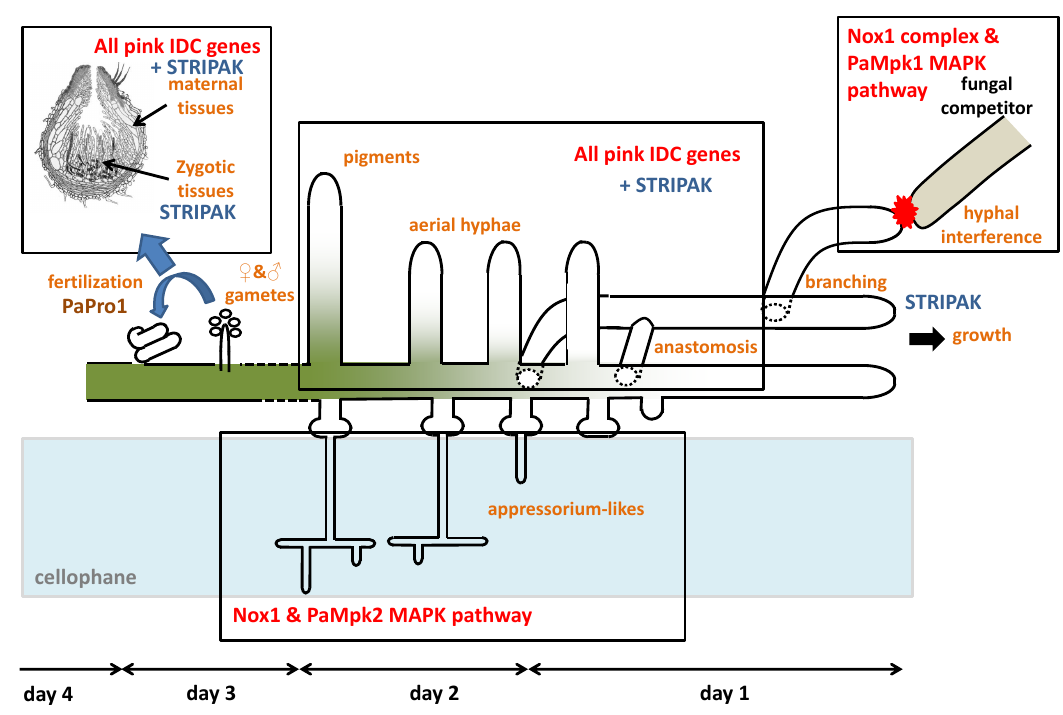
Figure 12. Scheme of the different developmental stages controlled by the IDC genes in P. anserina